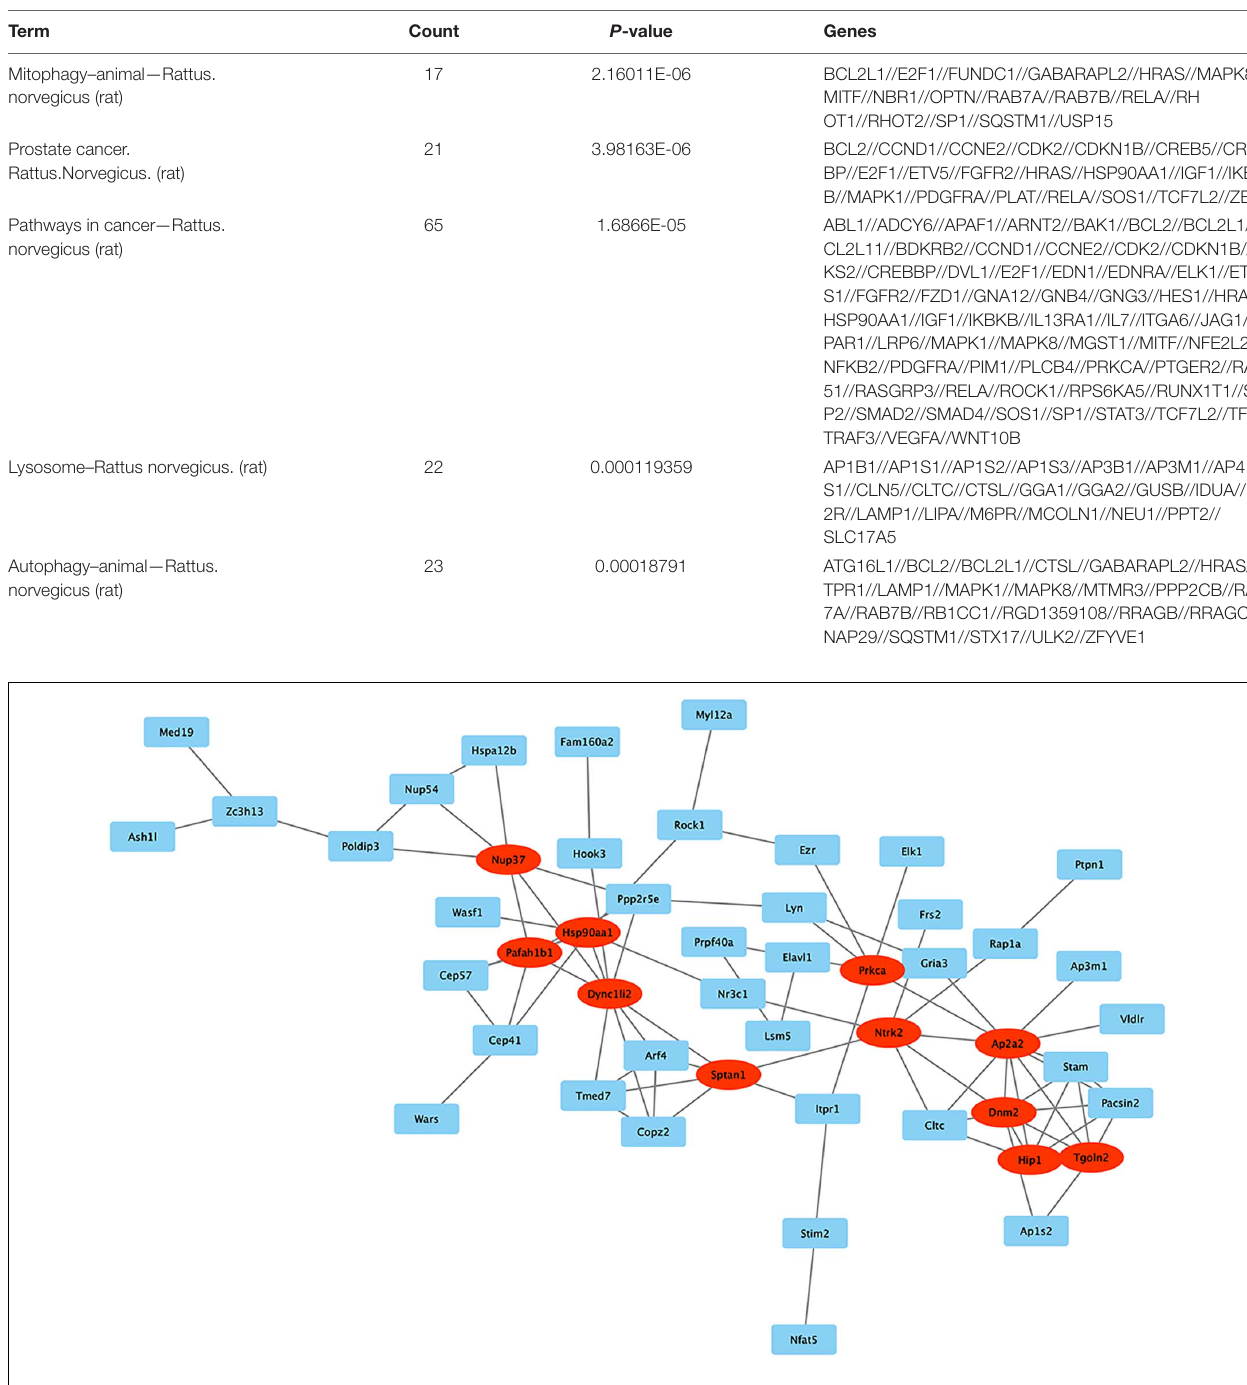
rno-miR-208a-5p. These miRNAs may be related to a variety of mRNAs, including Ces2h, Tmem47, and Nova1. Decreased Nova1 in the aged brain might be due to general neuronal aging, as neurons are subjected to increased oxidative stress,